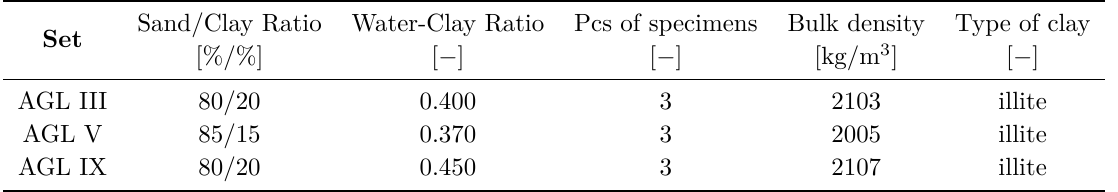
Table 1. Composition of designed mixture for rammed earth.